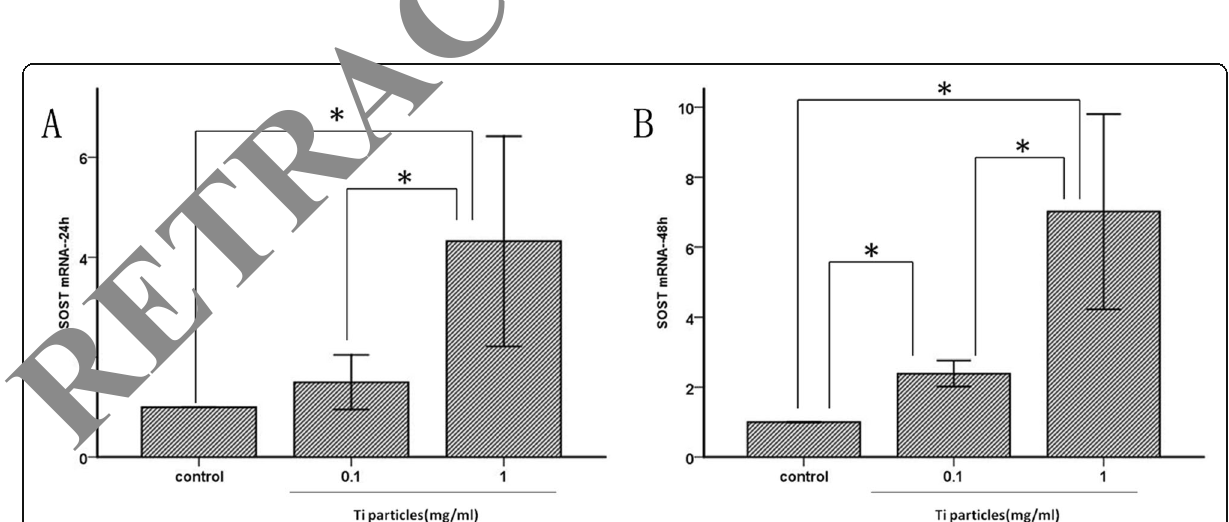
Fig. 4 mRNA expression of SOST in MLO-Y4 cells treated with Ti particles (0 (control), 0.1 mg/mL and 1.0 mg/mL) for 24 h and 48 h. Real-time PCR was performed, and GAPDH was used as an endogenous control. Results are expressed as the fold change relative to the control group. a At 24 h, treatment with 1.0 mg/mL of Ti particles significantly increased SOST mRNA expression compared with the control group (* p < 0.05). b At 48 h, treatment with 0.1 mg/mL or 1.0 mg/mL of Ti particles significantly increased SOST mRNA expression compared with the control group (* p < 0.05). The group treated with 1.0 mg/mL of Ti particles also differed significantly from the group treated with 0.1 mg/mL (* p <